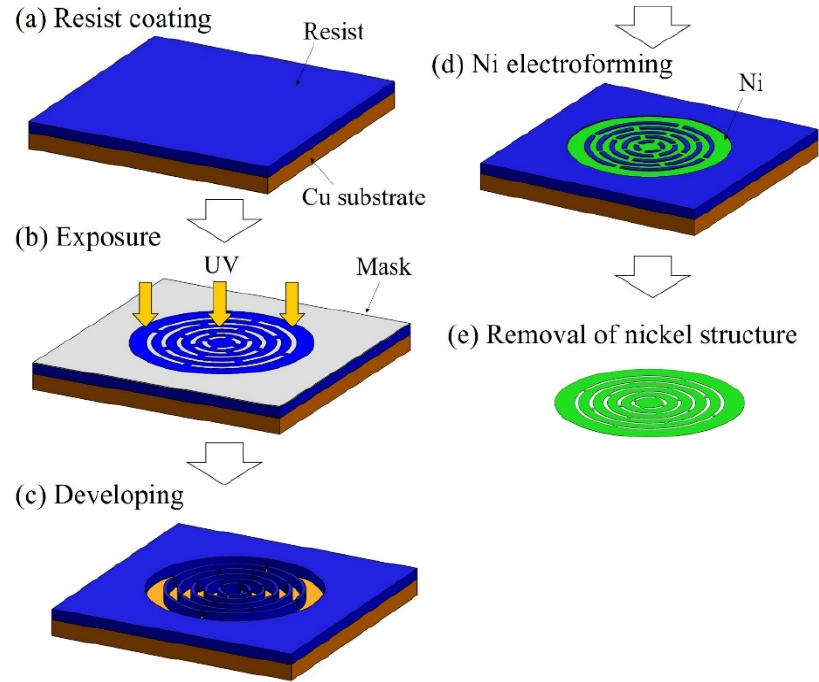
Figure 7. Schematic of the precision electroforming process. ( a ) A photoresist is applied on a Cu substrate. ( b ) Curing of photoresist by ultraviolet irradiation. ( c ) Mold creation by developing the photoresist. ( d ) Fabrication of Ni metal structures on Cu substrates by Ni electroforming. ( e ) Removal of the Ni structure to obtain a metal structure of the desired shape.